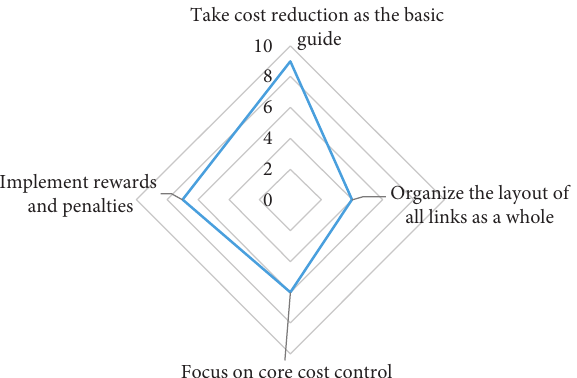
Figure 3: Radar chart of influencing factors of SCC control.